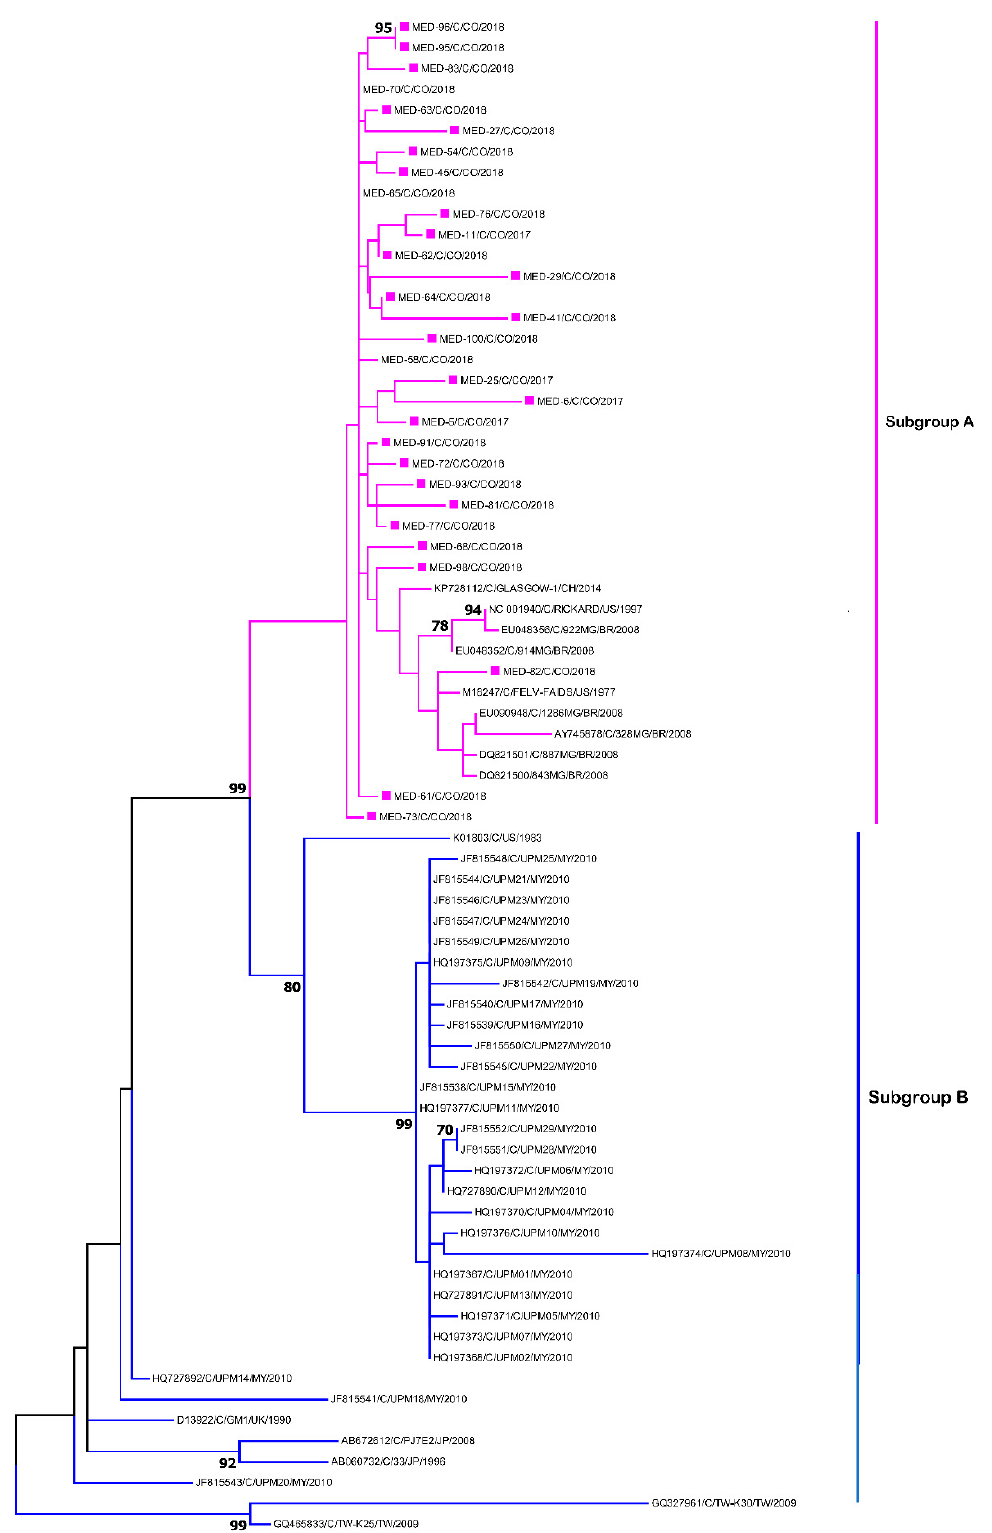
Figure 2. Phylogenetic tree of the U3LTR-GAG segment of feline leukemia virus (FeLV) using the maximum parsimony bootstrap of 1000 repetitions. Pink squares represent Colombian sequences.